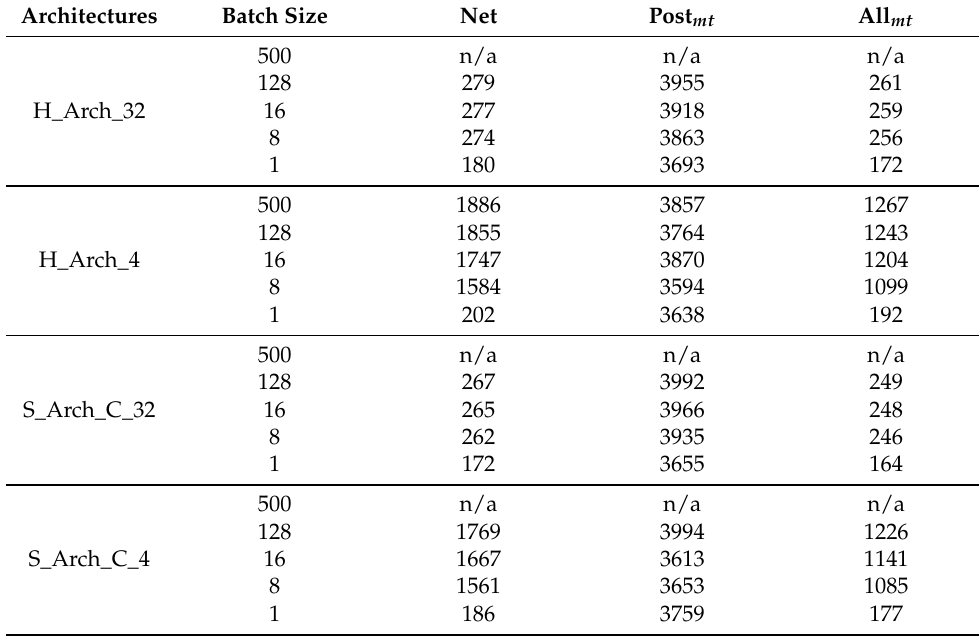
Table 9. FPS with different